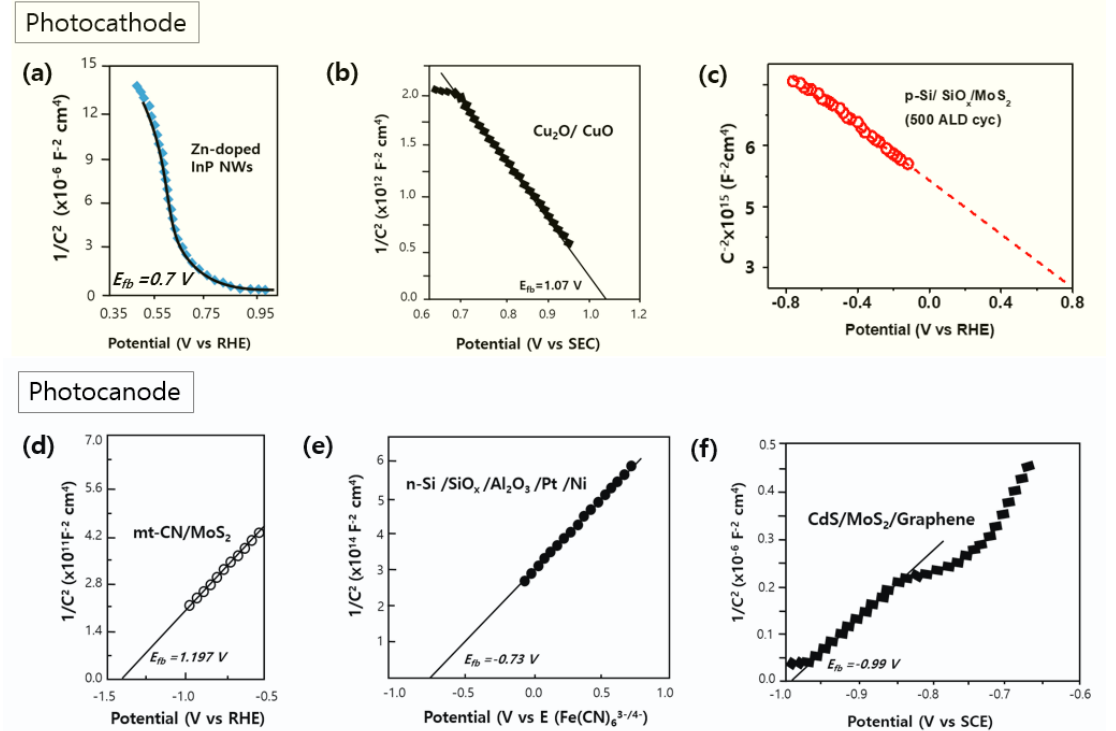
Figure 9. Mott–Schottky plots from various photoelectrodes: ( a – c ) photocathodes, and ( d – f ) photo anodes. (a) is adapted from reference [54]. Copyright (2016) American Chemical Society. (b) is adapted from reference [55] with permission from The Royal Society of Chemistry. (c) is adapted